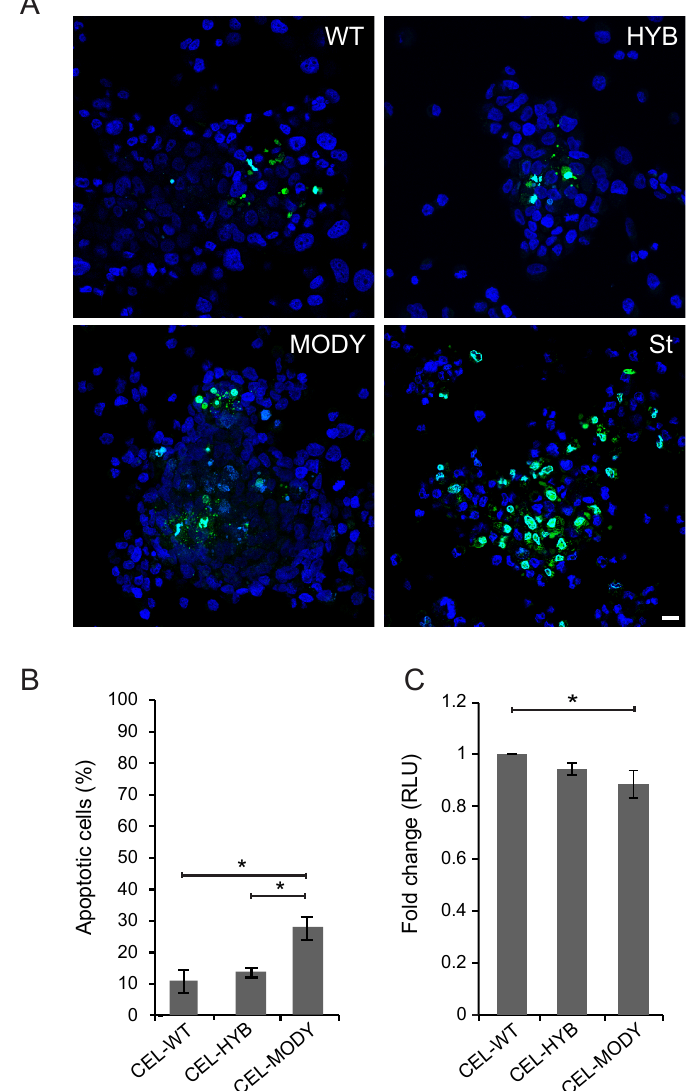
Figure 5. E ff ect of endocytosed CEL variants on apoptosis and viability of pancreatic ductal cells. PANC-1 cells were grown for seven days in the presence of conditioned medium containing CEL-WT, CEL-HYB, or CEL-MODY. ( A ): Apoptosis was assessed by visualization of caspase-3 / 7 activity in the PANC-1 cells exposed to di ff erent CEL protein variants. As positive control, cells were treated with 0.5 µ M staurosporine (St). Scale bar is 50 µ m. ( B ): Quantification of the experiment showed that CEL-MODY displayed significantly elevated caspase-3 / 7 activity compared with CEL-WT and CEL-HYB. For each variant, a total of 300–400 cells were counted in three independent experiments. Error bars represent SEM (n = 3); * denotes p < 0.05. ( C ): Cell viability was analyzed by measuring the intracellular level of ATP. PANC-1 cells exposed to CEL-HYB exhibited reduced but nonsignificant viability compared with cells exposed to CEL-WT, whereas CEL-MODY resulted in significantly reduced viability. The experiment was repeated two times, each with 11–12 parallels per condition. Error bars represent SEM (n = 2); * means p < 0.05. RLU, relative light